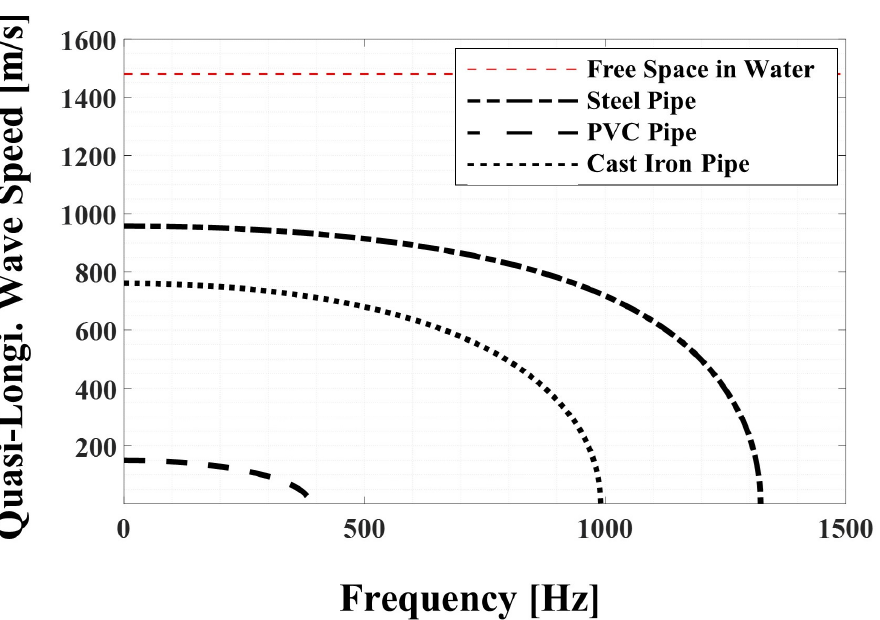
Figure 3. Dispersion curve of a quasi-longitudinal wave depending on the materials.